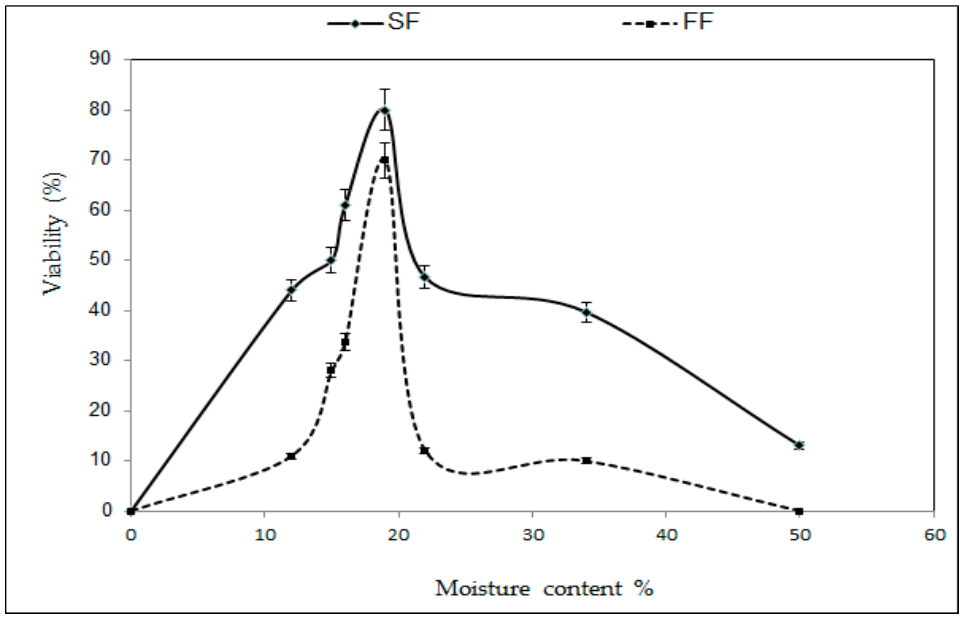
Figure 3. Relationship between moisture content% and viability% after slow freezing (SF) and fast freezing (FF) using fast thawing in M. indica. Error bars showing mean values ±SD (n = 3).